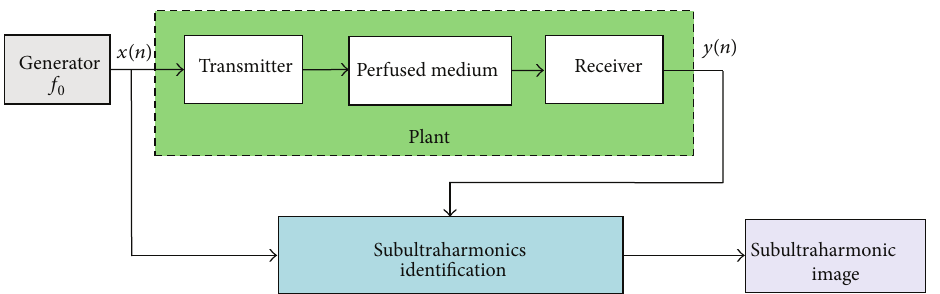
Figure 2: Block diagram of subultraharmonic imaging.